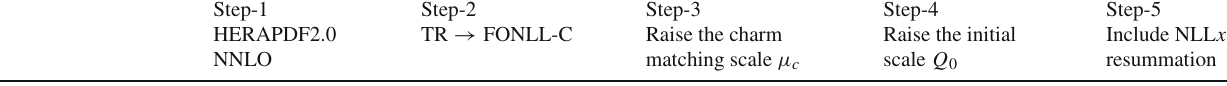
Table 1 The χ 2 per degree of freedom (d.o.f.) for PDF fits under different conditions, starting from the settings of the HERAPDF2.0 analysis at NNLO Step-1 Step-2 Step-3 Step-4 Step-5 HERAPDF2.0 TR → FONLL-C Raise the charm Raise the initial Include NLL x NNLO matching scale μ c scale Q 0 resummation HERA χ 2 / d . o . f .